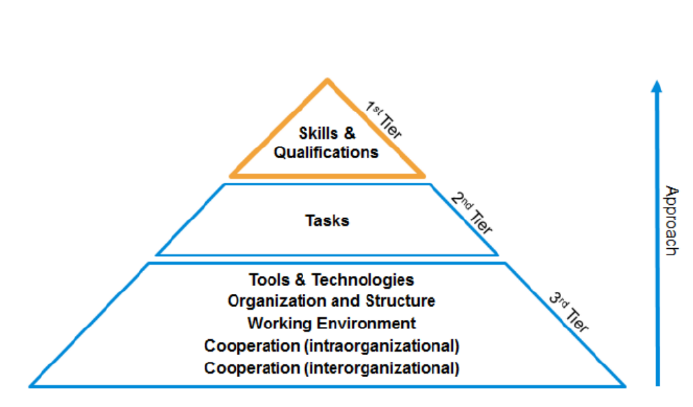
Source: Gehrke et al.,